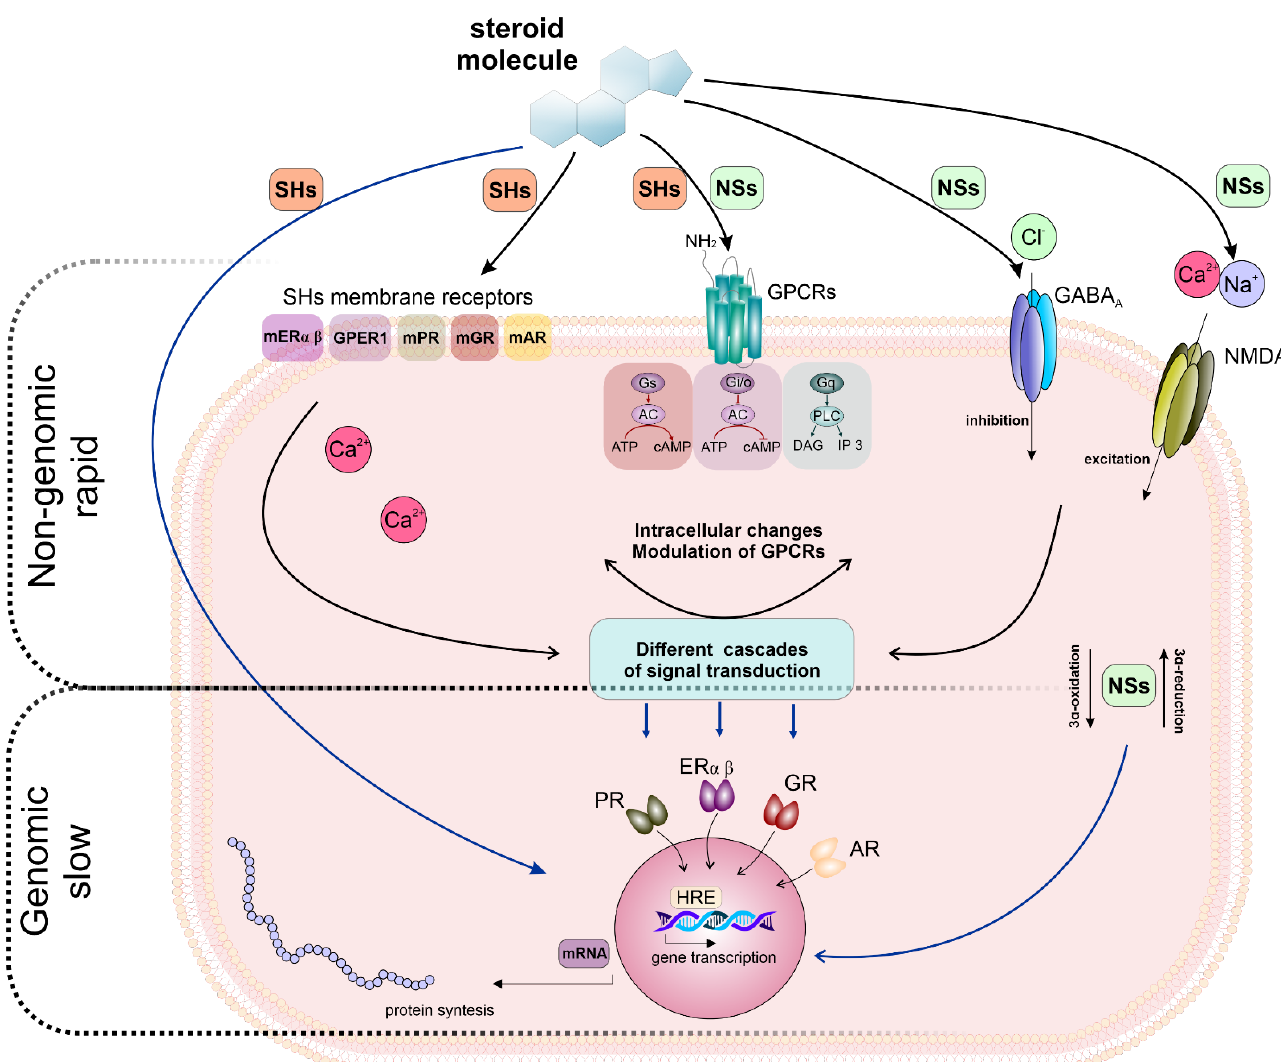
Figure 4. The interplay between genomic and non-genomic effects of steroids. Top , non-genomic, rapid (seconds to minutes) signaling: the activation of membrane-localized receptors for estrogen (mER α ; mER β ; GPER1/GPR30), progesterone (mPR), glucocorticoids (mGR) and androgens (mAR) by a specific hormone modulates numerous signaling cascades and produces different cellular ef- fects [95,96]. NSs exert their rapid, non-genomic effects via modulation of membrane ionotropic receptors and channels, e.g., γ -aminobutyric acid receptors, GABA A or NMDA receptors, resulting in excitability changes within neurons. Activation of G s protein results in stimulation of adenylyl cyclase (AC) and cAMP synthesis; activation of G q/11 protein results in the activation of phospholipase C (PLC) and production of inositol 1,4,5-trisphosphate (IP 3 ) and diacylglycerol (DAG); activation of G i/o proteins inhibits AC and cAMP synthesis. Middle , metabolites of neurosteroid (NSs) produced by intracellular oxidation bind to steroid receptors [33,35]. Bottom, slow genomic effects (minutes to hours): steroid hormones (SHs) bind to their specific intracellular class I nuclear receptors (proges- terone receptor (PR), oestrogen receptors (ER α and β ), glucocorticoid receptors (GR) or